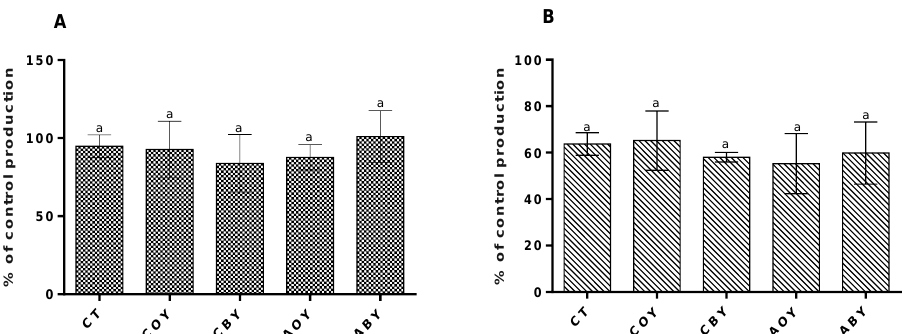
Figure 3. Hepatic lipid accumulation results for the different yogurts ( A ) without induced steatosis; ( B ) steatosis induced. Different letters mean significant differences between yogurts as determined by a one-way ANOVA test ( p < 0.05). CT—control yogurt, COY—coconut oil yogurt; CBY—coconut bigel yogurt; AOY—avocado oil yogurt; ABY—avocado bigel yogurt. No significant differences ( p ˃ 0.05) were observed between the control and fortified